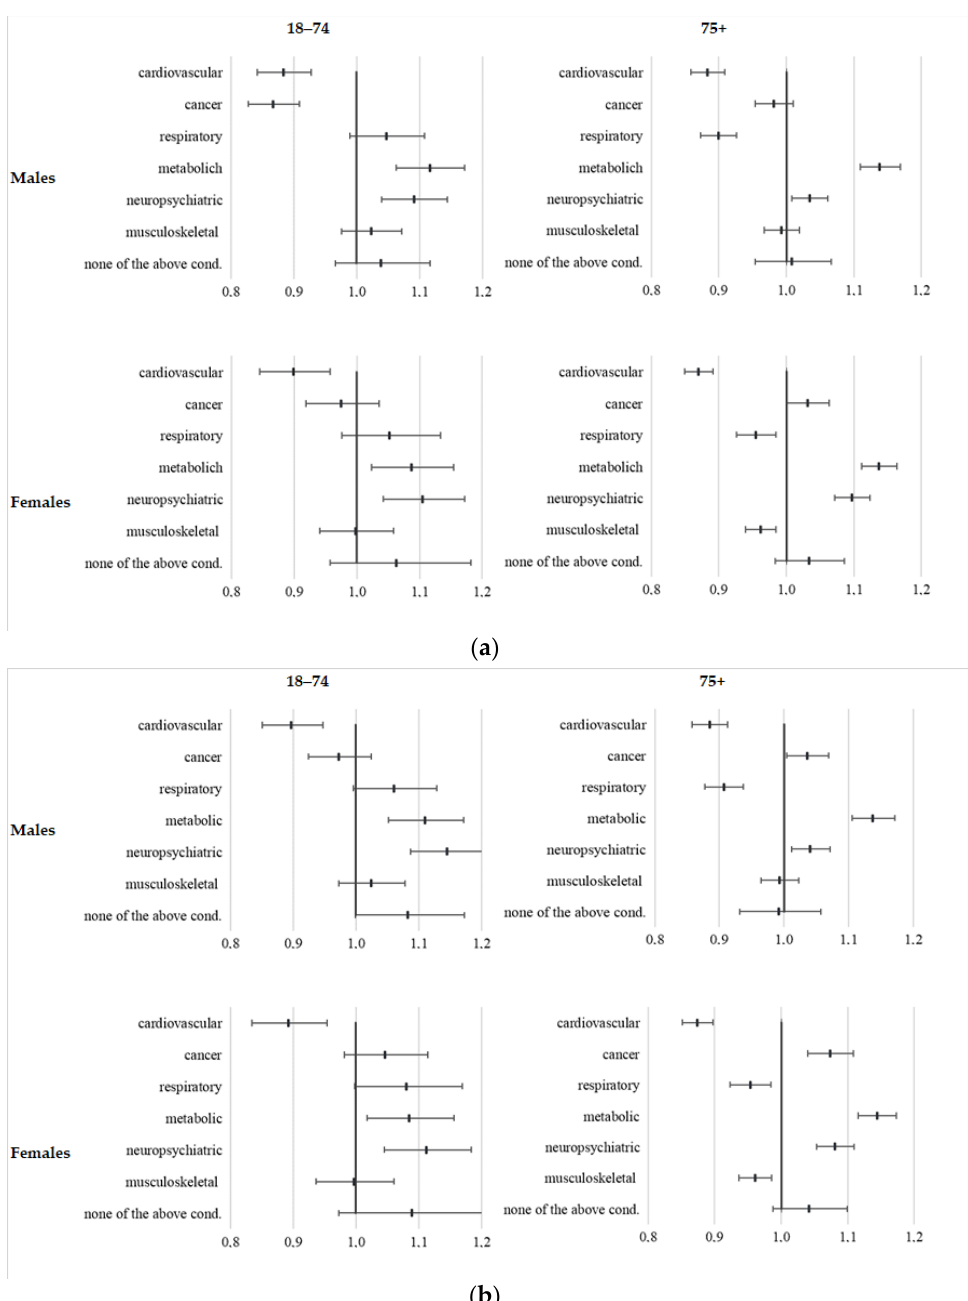
Figure 2. ( a ) Prevalence ratios of pre-existing chronic conditions among deceased, 2020 vs. 2015–2019, by sex and age group, Emilia-Romagna. ( b ) Prevalence ratios of pre-existing chronic condition among not COVID-19 deceased, 2020 vs. 2015–2019, by sex and age group,